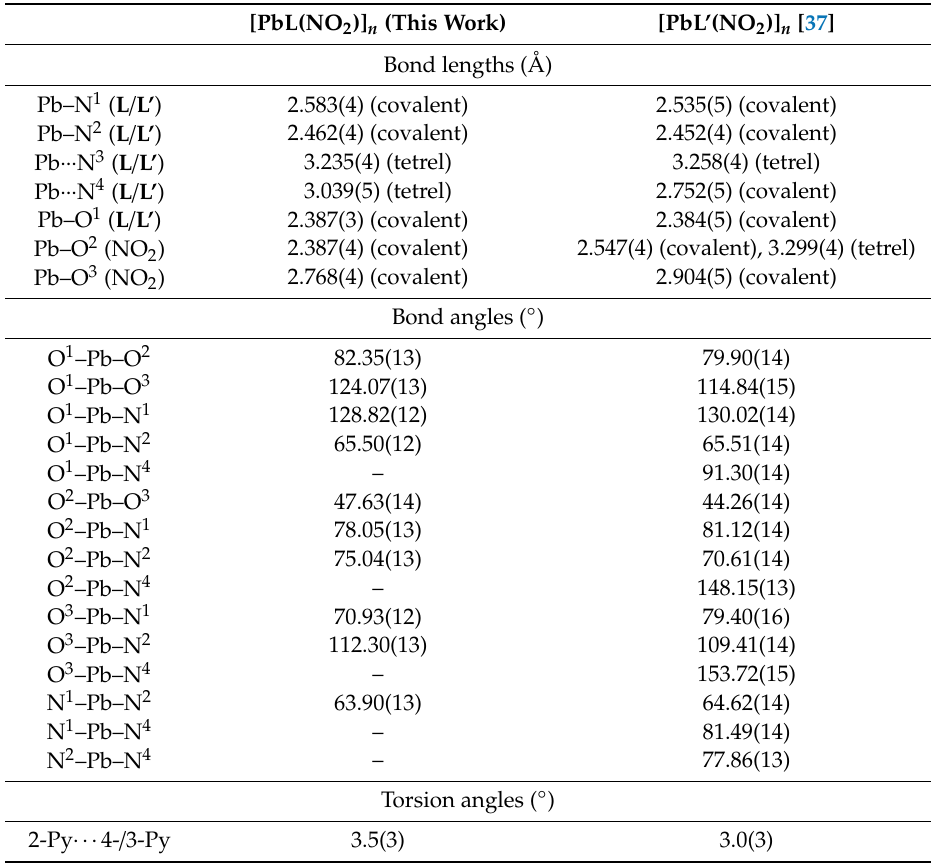
Figure 1. Molecular structure of the [PbL(NO 2 )] unit in the structure of [PbL(NO 2 )] n (ellipsoids are drawn at 50% probability level). Color code: H = black, C = gold, N = blue, O = red, and Pb = magenta. Table 1. Selected bond lengths (Å) and bond and torsion angles (°) in the structures of [PbL(NO 2 )] n and [PbL’(NO 2 )] n a .